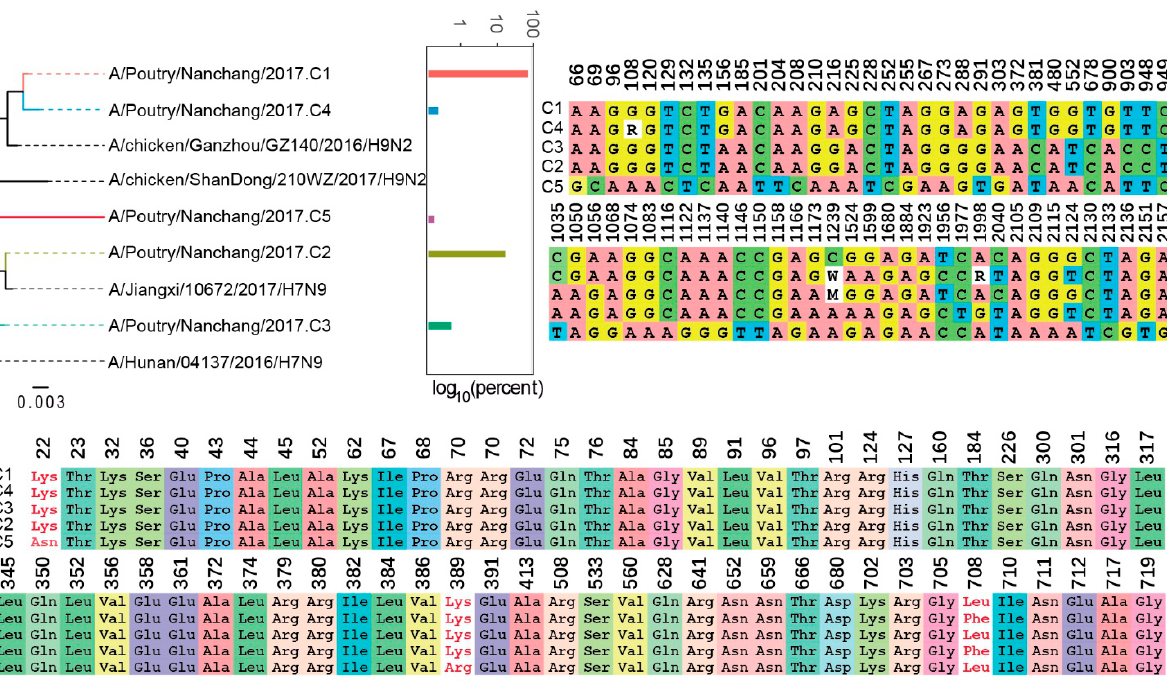
Figure 5. Phylogenetic analysis of influenza virus genome PB2 segment clonotypes. ( a ) Phylogenetic relationship, sequence abundance and sequence alignment of five clonotypes of PB2 segments. Numbers above alignment indicated the location of clonotype bases, and white background were redundant bases. ( b ) Alignments of corresponding amino acid residues of PB2 clonotypes.